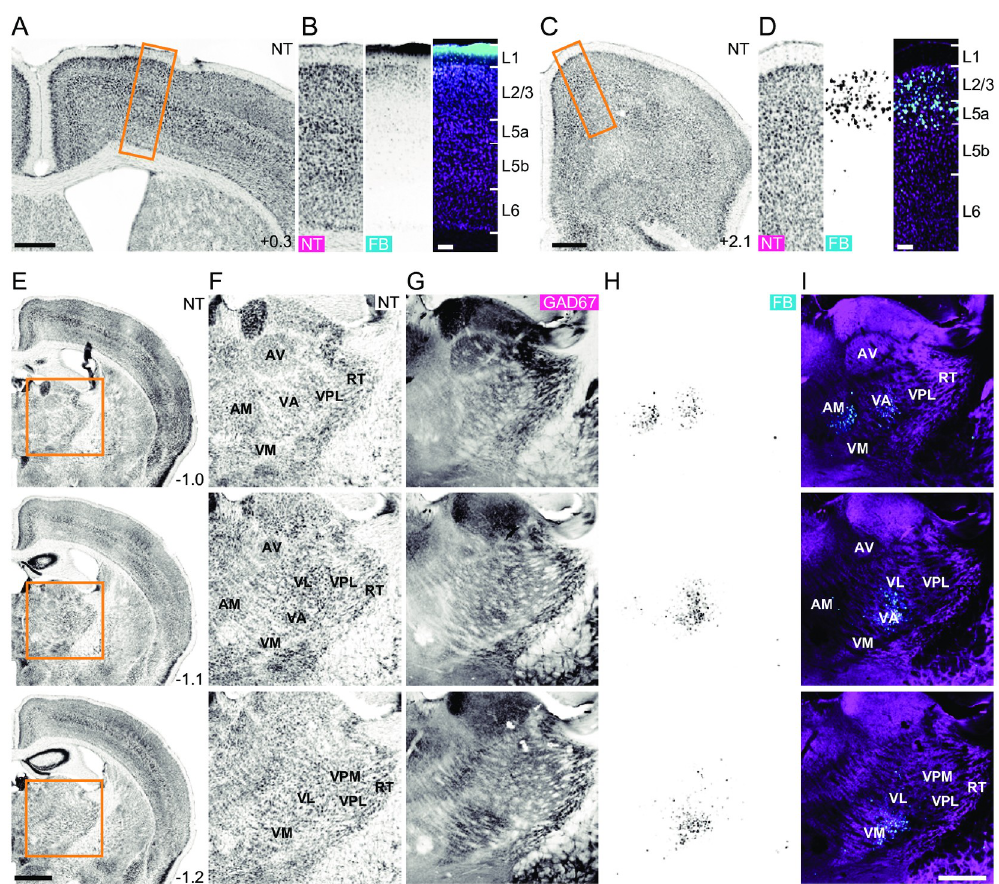
Fig 1. L1 in M1 receives axonal inputs from M2 and the motor thalamus. (A) NeuroTrace (NT) fluorescence in a coronal section including the Fast Blue (FB) immersion site in M1. Scale bar, 500 μ m. (B) NT (left) and FB fluorescence (middle), and overlay image (colored magenta for NT and cyan for FB; right) of the boxed area in (A). Scale bar, 100 μ m. (C) NT fluorescence in M2. Scale bar, 500 μ m. (D) NT (left) and FB (middle) fluorescence, and overlay image (colored in magenta for NT and cyan for FB; right) of the boxed area in (C). Scale bar, 100 μ m. (E) NT fluorescence in coronal sections including the motor thalamus. Scale bar, 1 mm. (F–H) Fluorescence images of NT (F), immunohistochemically stained GAD67 (G), and FB (H) in the boxed area in (E). (I) Overlay image of (G; magenta) and (H; cyan). Scale bar, 500 μ m. The anteroposterior distance (mm) from the bregma is shown in the lower right corner of (A), (C), and (E). AM, anteromedial nucleus; AV, anteroventral nucleus; VA, ventral anterior nucleus; VL, ventral lateral nucleus; VM, ventral medial nucleus; VPL, ventral posterolateral nucleus; VPM, ventral posteromedial nucleus; RT, reticular nucleus. labeled axons and their en passant boutons in L1 of M1 in anesthetized mice (Fig 2B–2D). The bouton size, which was estimated from the fluorescence intensity [46] (see Materials and methods for details), was larger in thalamic boutons than in M2 boutons (p = 2.65 × 10 − 11 , Kolmogorov– Smirnov test; Fig 2E). This result is consistent with previous studies showing that thalamocortical